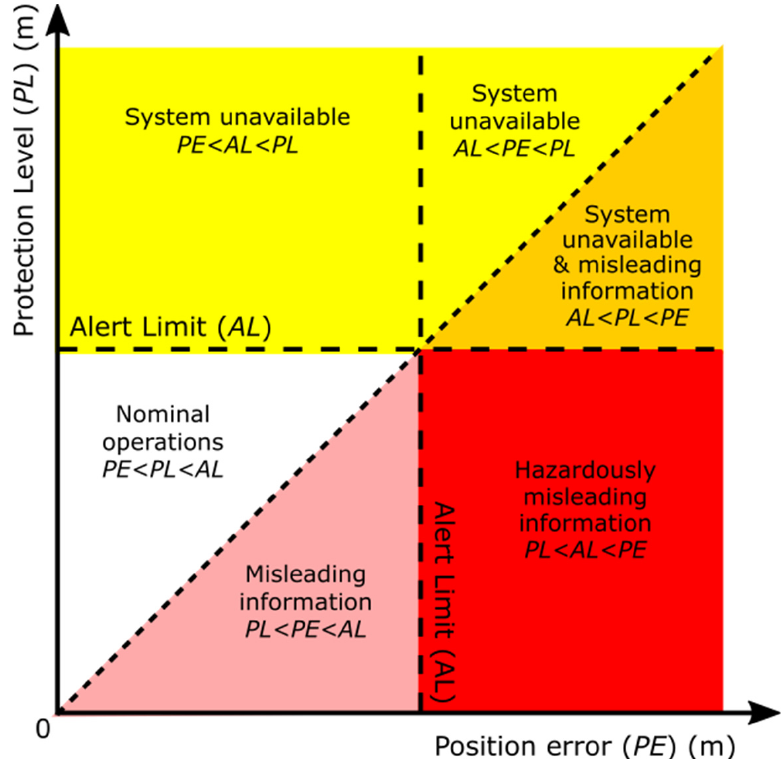
Figure 11. Interpretation of Stanford diagram based on 4 relations of system availability (based on [38]).